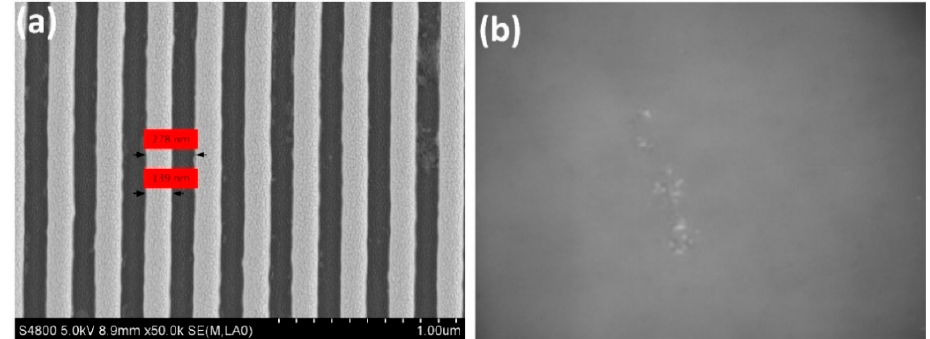
Figure 4. ( a ) The SEM image of the silicon nanostructure grating (SNG) with a period of 278 nm and a 139-nm line-width. ( b ) The imaging of the SNG without microspheres, from which we cannot visualize the grating structure due to the di ff raction